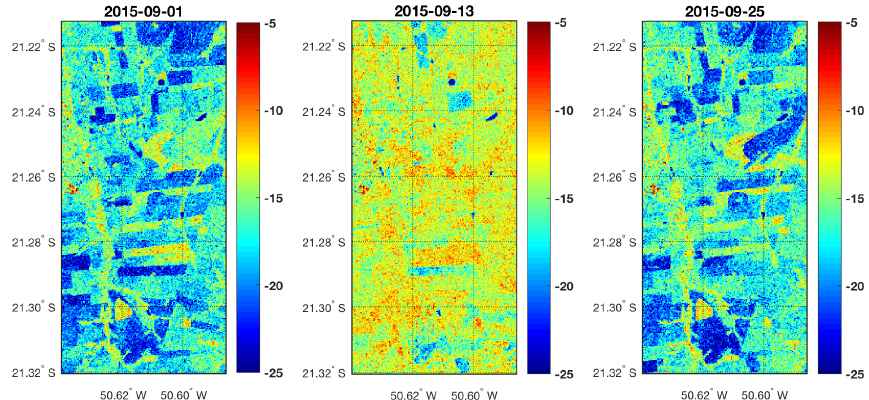
Figure 2. Three consecutively-acquired Sentinel-1 Interferometric-Wide (IW) images over the same area illustrating the effects of precipitation on VH backscatter (in dB). The area spans approximately 5 by 10 km. The right and left images show the backscatter, average − 15.8 dB and − 15.5 dB, respectively, when at least two days of dryness occurred. The middle image, average − 13.0 dB, shows the same location with 40 mm of precipitation on the day before the acquisition and 15 mm on the day of acquisition. The blue patches in the dry images are most of all marginally vegetated (harvested fields or early stage crops), and the yellow and red patches are vegetated (mature crops or